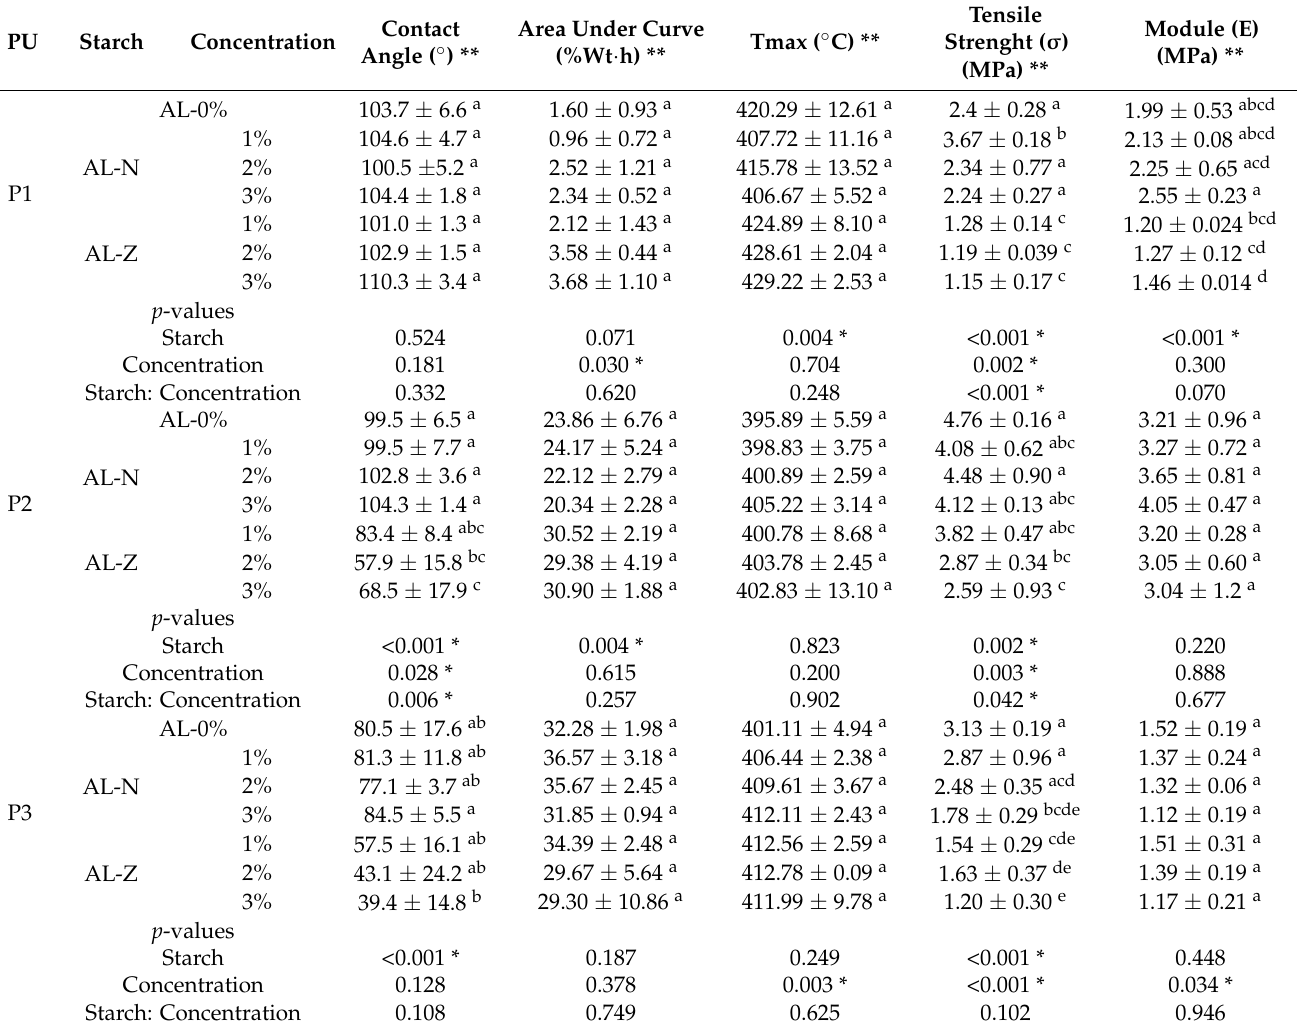
Table 2. Physical and mechanical parameters of polyurethane composites, and ANOVA summary of water contact angle, area under the curve of water absorption, maximum temperature of degradation, and tensile strength and